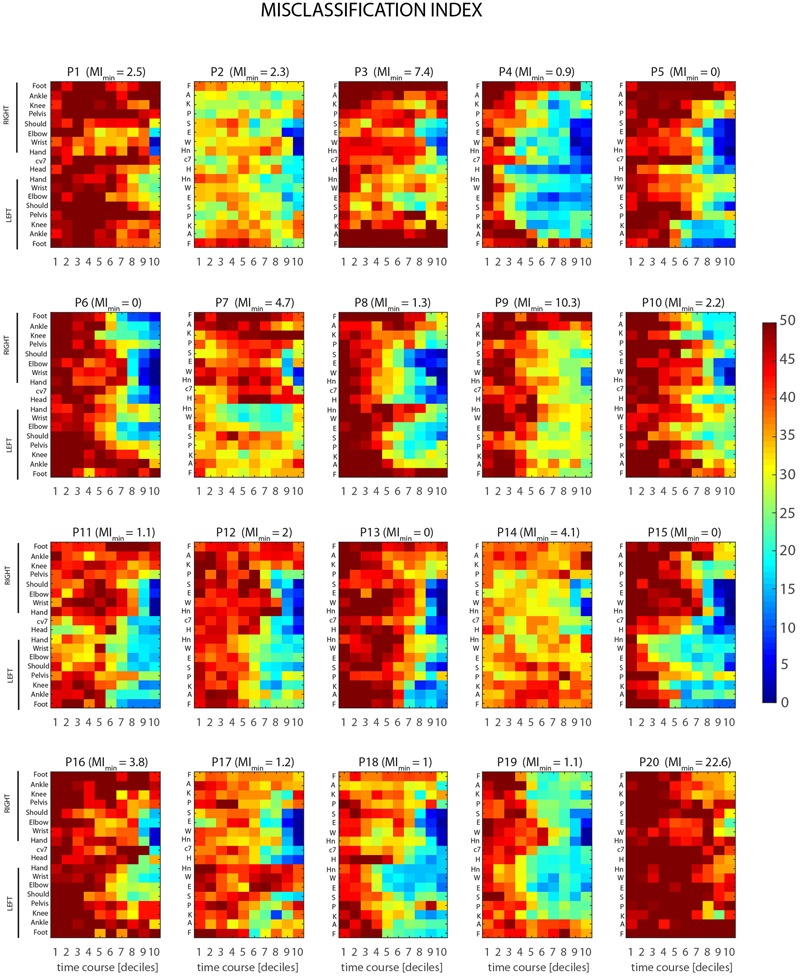
Individual spatio-temporal structures of predictability. Color maps represent the misclassification index, MIBK (see Section Ball Flight Predictability based on Throwing Kinematics), as a function of joint-marker and time decile throughout the course of the throwing action, for all the twenty participants recruited in the study. Marked inter-individual differences show that different participants are characterized by different overall levels of predictability (MIBK values on the top of each map gives the individual minimum value of MIBK across joint-markers and time intervals). Furthermore, different participants become predictable at difference stages of the action, with relevant information provided by subject-dependent key joint-markers.